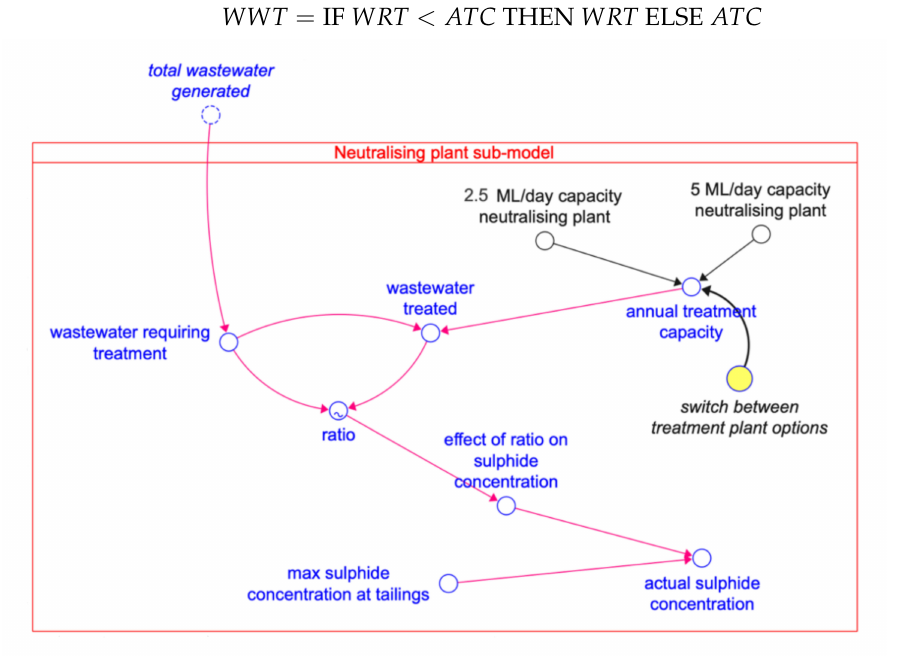
Figure 5. Sub-model 3 represents the neutralising treatment plant sub-model. Variables with the ‘~’ symbol denote either graphical functions or where a LOOKUP data table is behind the